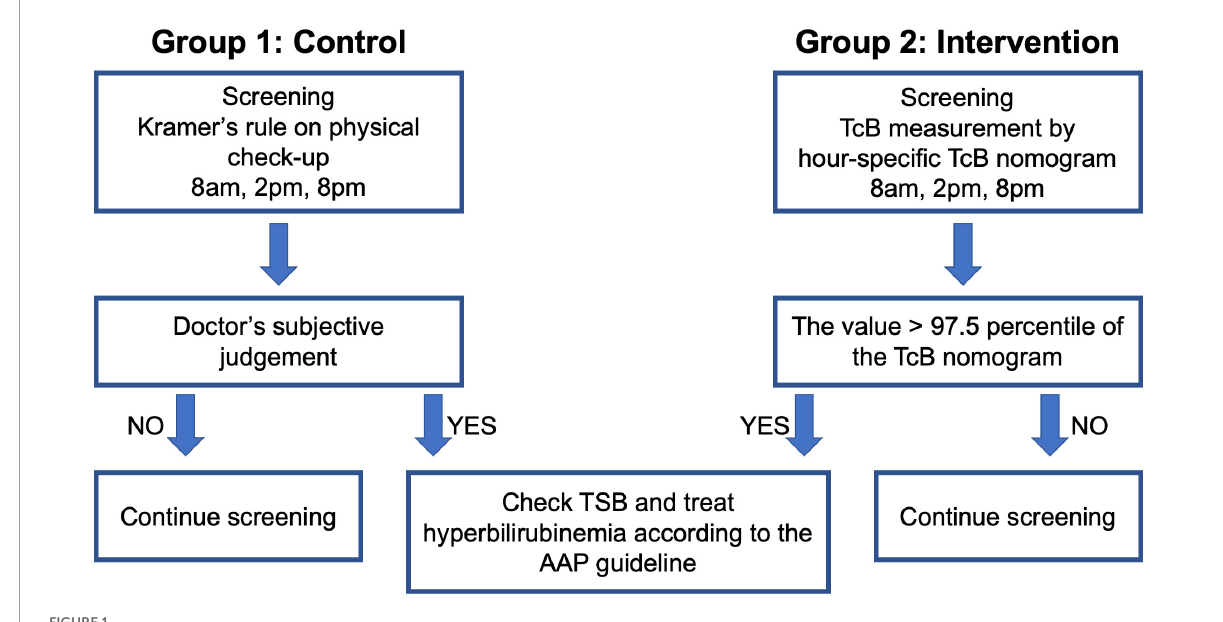
FIGURE1 Algorithm of the control and intervention groups for the treatment of hyperbilirubinemia.